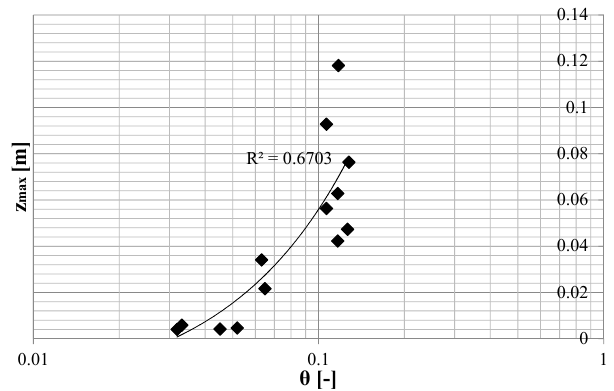
Figure 11. Shields parameter and the maximal scour depth correlation graph, where θ — dimensionless shear stress in bed region; z max —maximal scour depth in clear water scour forming process; R 2 —coefficient of determination.